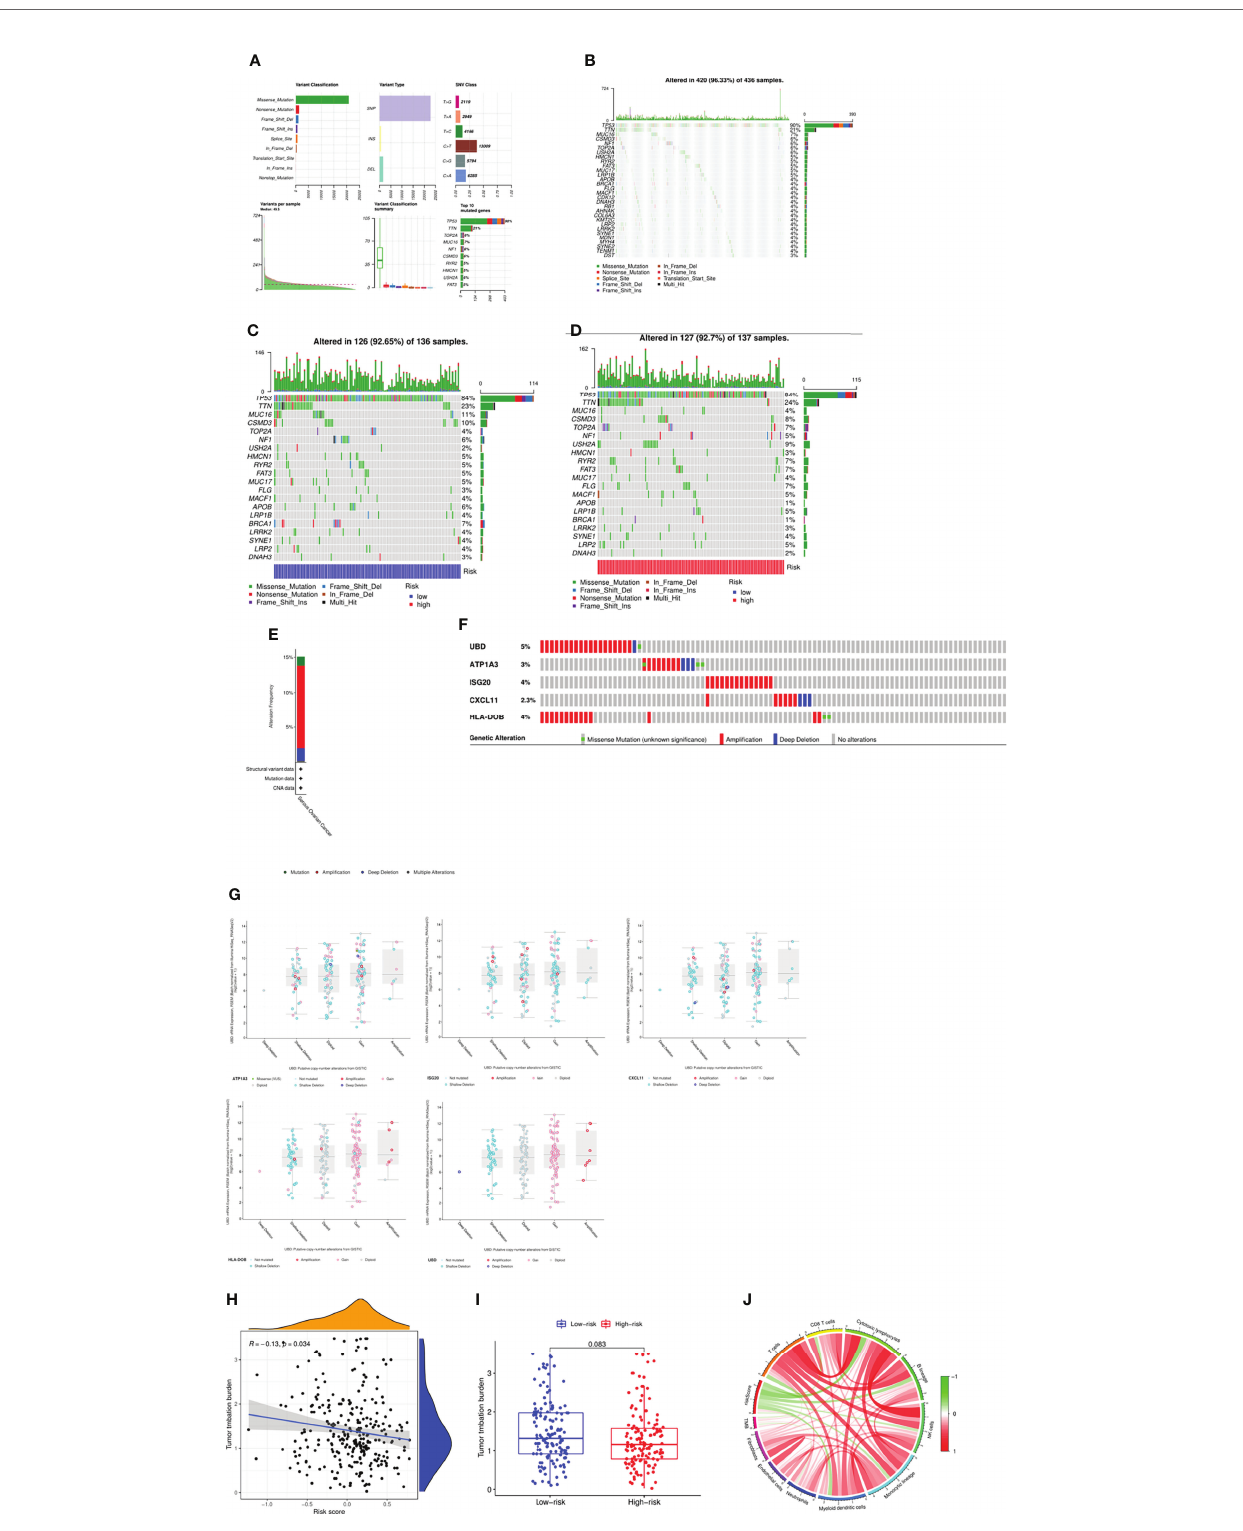
FIGURE 6 | Mutation spectrum of the patients between two groups. (A, B) Mutation pro fi le of the patients in TCGA cohort. (C) Mutation pro fi le of the patients in low-risk group. (D) Mutation pro fi le of the patients in high-risk group. (E) Frequency of mutation in hub genes in serous ovarian cancer. (F, G) Mutation of each hub gene. (H) Correlation between TMB and risk score. (I) Comparison of TMB between two groups. (J) Link between the TMB, risk score and the immune